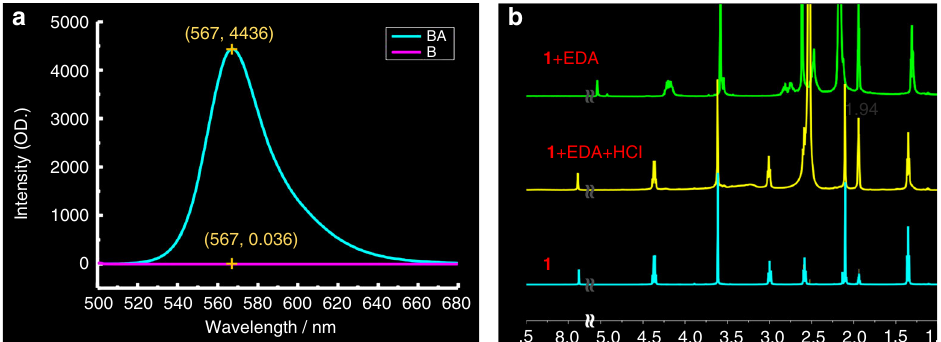
Fig. 5 High turn-on ration and 1 H-NMR recover results. a A concentration of 10 − 4 M 1 ethanol solution mediated with NH 2 NH 2 /HCl; BA denotes adding acid to base treated (denoted as B) colorless solution; S/N = 4436/0.036. b 1 H-NMR experiments, 1 + EDA + HCl denotes add HCl to the colorless 1 + EDA solution; δ 2.56 is ascribed to -CH 2 CH 2 - of EDA or EDA-HCl, δ 1.94 is CD 3 CN